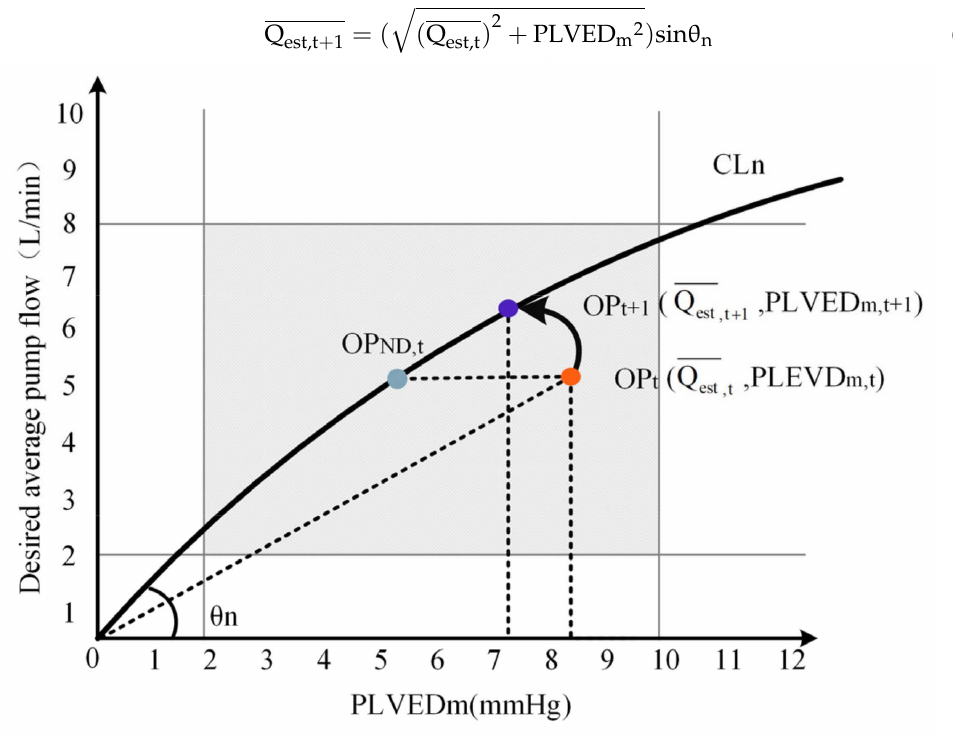
Figure 3. Pump flow regulator. OP ND,t , the original operating point; OP t , the unadjusted state point of the patient at time t; Q est,t , the pump flow of the patient at time t; OP t+1 , the state point after the patient adjusts at t+1; Q est,t + 1 , the ideal pump flow after the patient adjusts at time t+1 (reference pump flow); θ n , the nth control angle of the operating angle of the